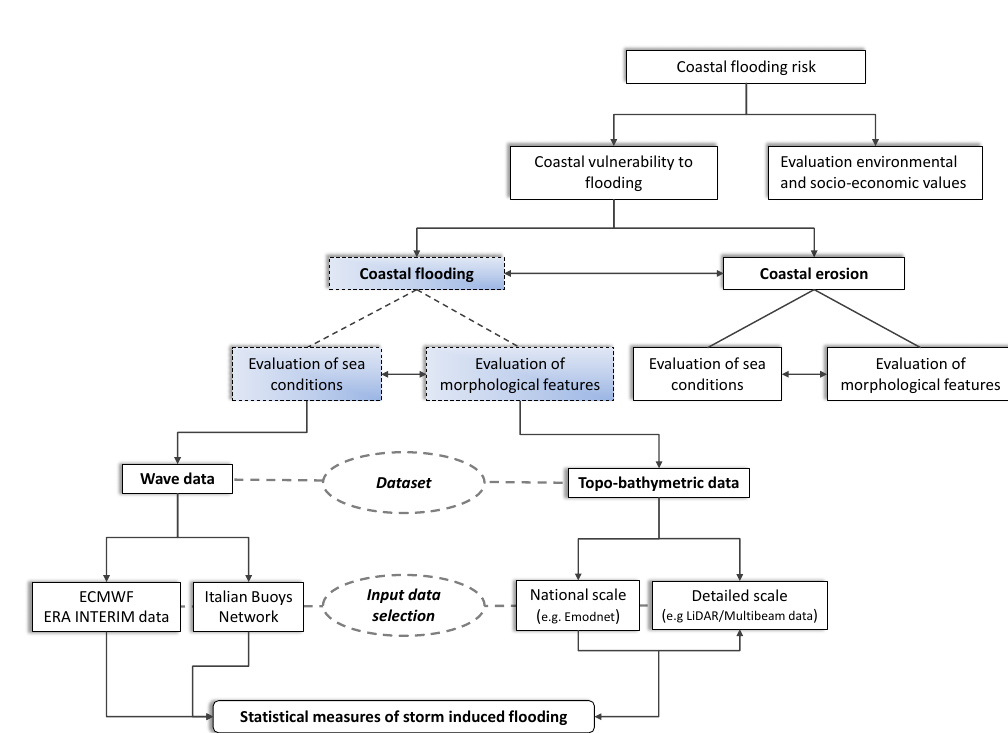
Figure 1. Workflow of risk assessment. The shaded boxes highlight the issues tackled in this